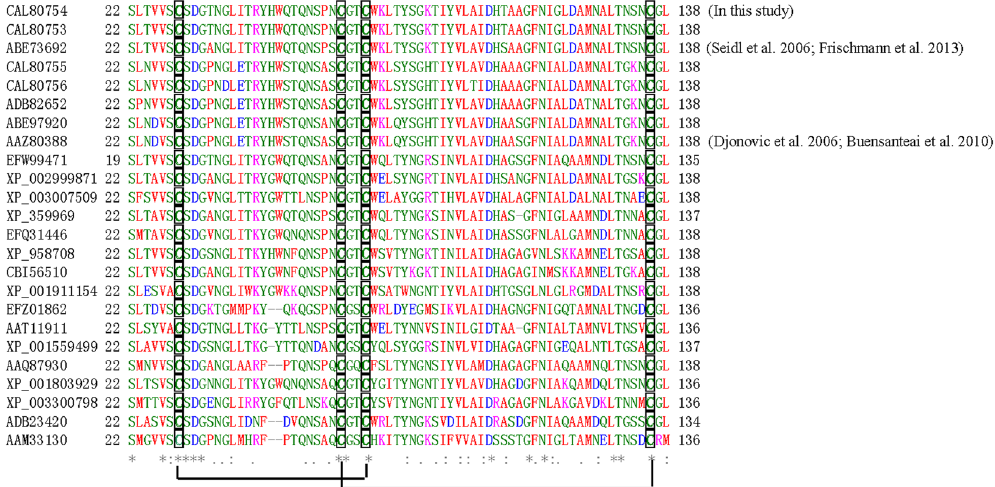
Figure 1. Multiple sequence alignment of sequence similar to Epl1-Tas from 25 fungal strains. Four highly conserved cysteine residues, C, are boxed, forming two disulfide bonds. Asterisk ( * ): identity. Colon (:): high similarity. Period (.): low similarity. CAL80754 and CAL80753: T . asperellum ; ABE73692: T . atroviride ; CAL80755 and CAL80756: T . viride ; ADB82652: T . reesei ; ABE97920 and AAZ80388: T . viren ;